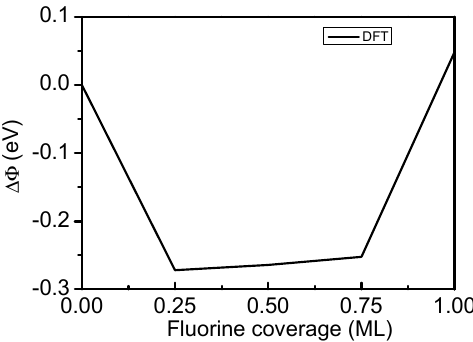
Figure 2. Change in the work function of the F-Ti(0001) surface as a function of fluorine coverage.